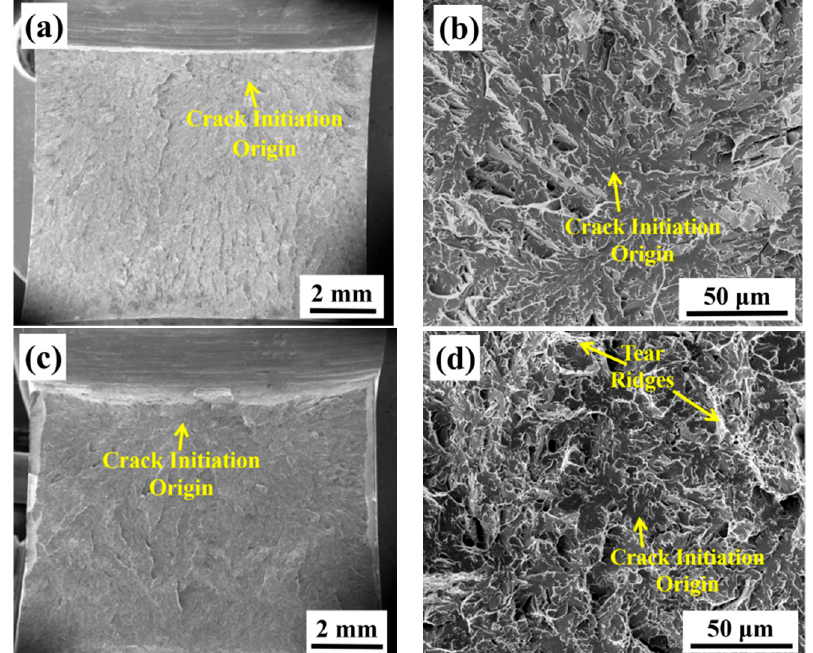
Figure 7. Fracture surface of as-welded specimen ( a,b ) and PWHT specimen ( c,d ).